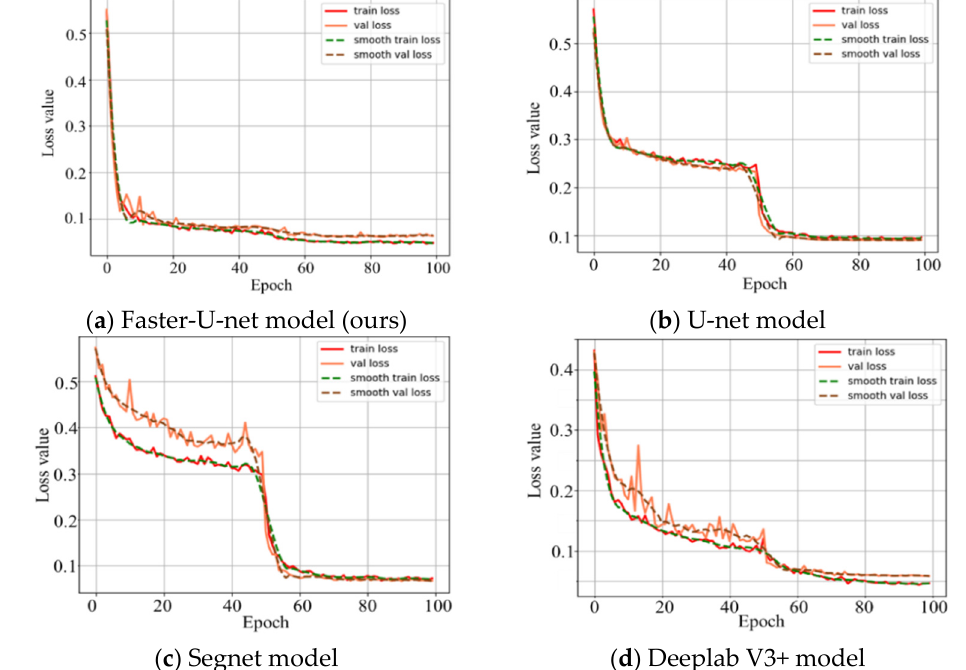
Figure 10. Model training loss function curves. ( a ) The loss function curve obtained based on the Faster-U-net model. ( b ) The loss function curve obtained based on the U-net model. ( c ) The loss function curve obtained based on the Segnet model. ( d ) The loss function curve obtained based on the Deeplab V3+ model.